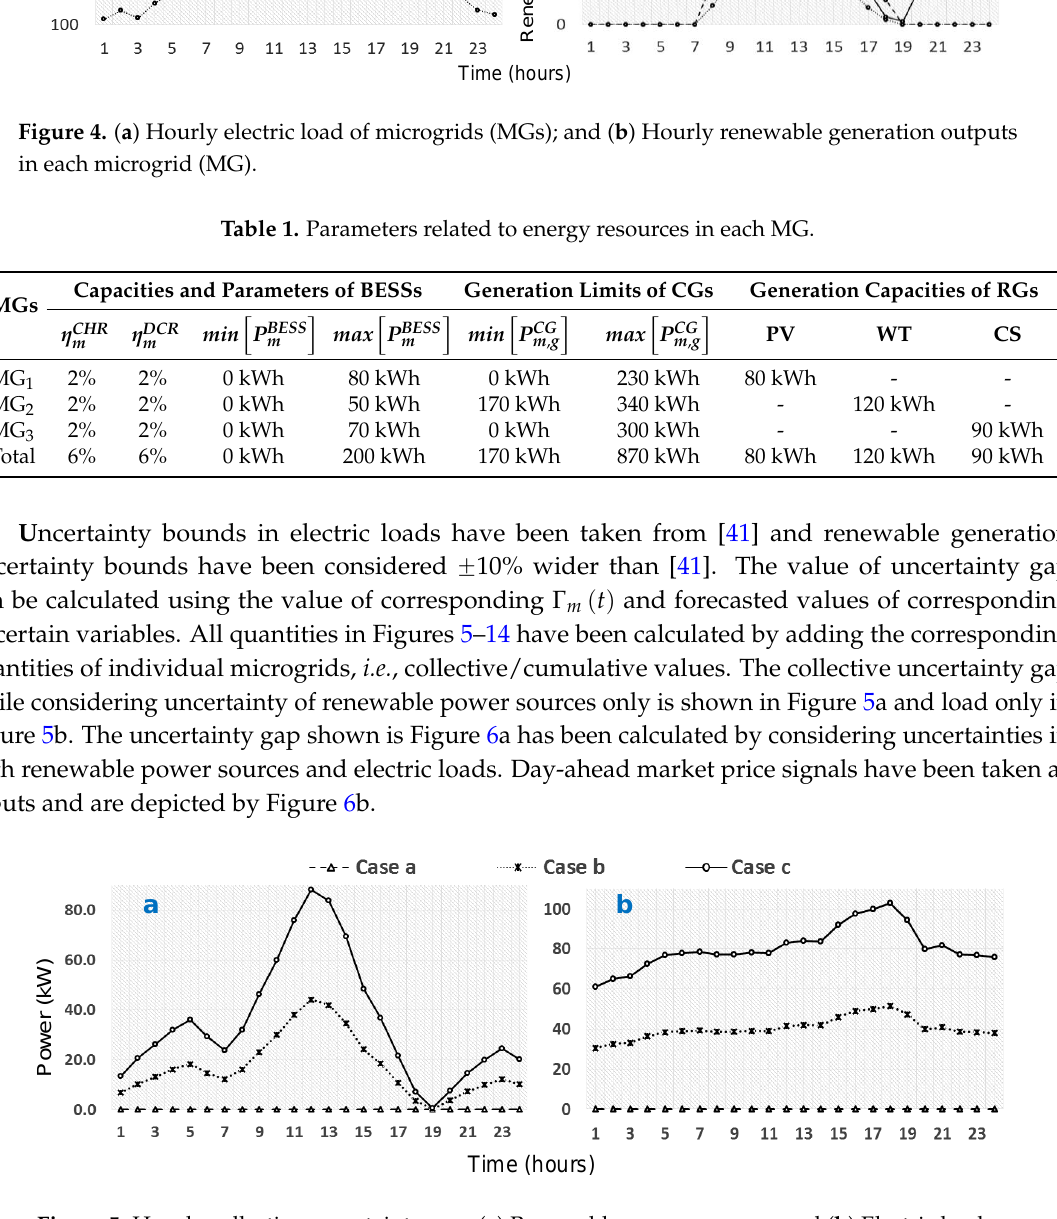
Figure 5. Hourly collective uncertainty gap: ( a ) Renewable energy sources; and ( b ) Electric loads.